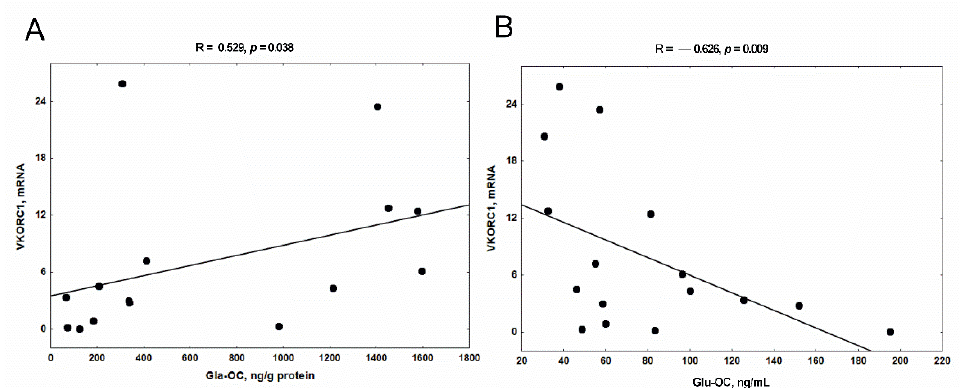
Figure 7. The association between bone VKORC1 expression and Gla ‐ OC levels in trabecular bone ( A ), and VKORC1 expression and Glu ‐ OC levels in serum of rats with CKD ( B ). MK4—menaquinone 4; BGLAP—bone gamma ‐ carboxyglutamate protein; VKORC1—vitamin K epoxide reductase complex subunit 1; Gla ‐ OC—carboxylated osteocalcin; Glu ‐ OC—undercarboxylated osteocalcin; CKD—chronic kidney disease.